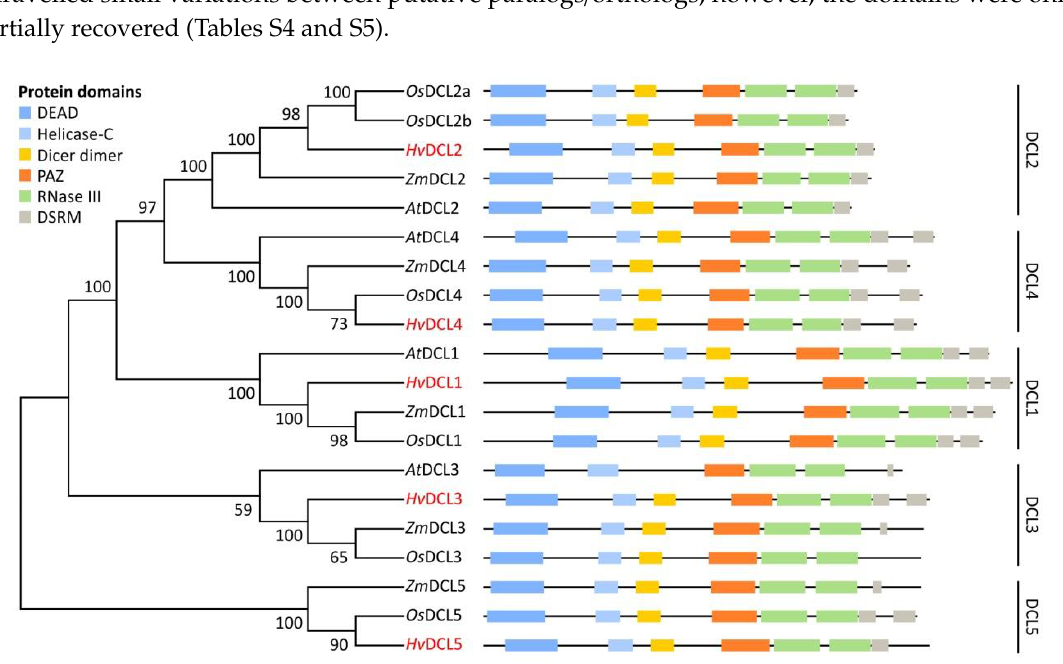
Figure 2. Phylogenetic relationship and conserved domains of A. thaliana , O. sativa, Z mays and H. vulgare DCL proteins. Unrooted NJ trees were constructed with MEGA X software as described in Figure 1 legend. The bootstrap values are shown next to the branches. Conserved domains were identified with the SMART server [84]. The protein domain abbreviations are the followings: DEAD (DEAD-like helicases superfamily), Helicase-C (helicase superfamily C-terminal domain), Dicer dimer (Dicer dimerisation domain, or DUF283), PAZ (Piwi, Argonaute, Zwille), RNAse III (Ribonuclease III family), DSRM (Double-stranded RNA binding motif). The barley DCLs identified in this study are marked with red.